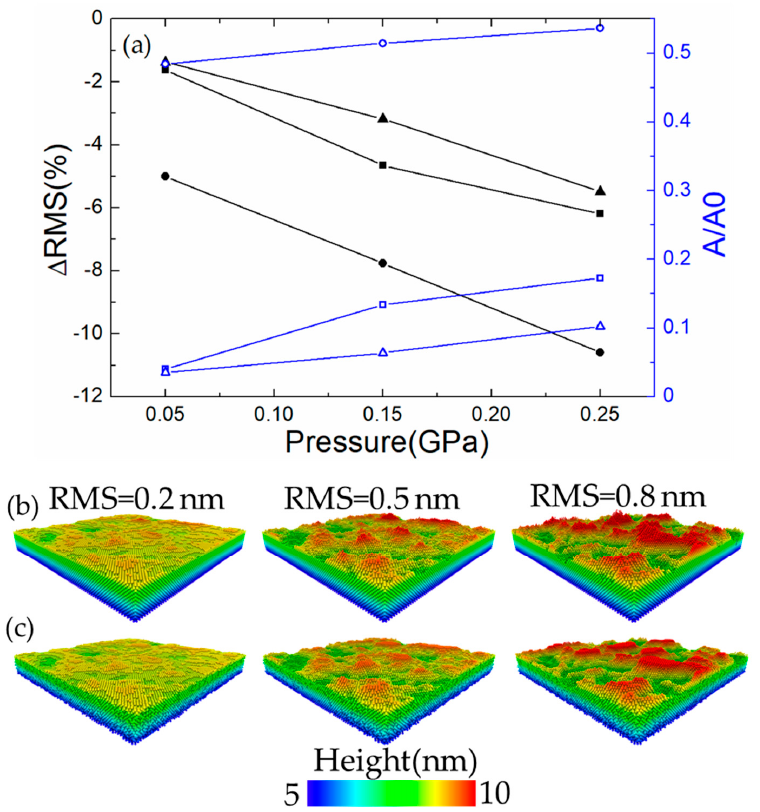
Figure 4. ( a ) RMS change ∆ RMS and contact area A / A0 of dry contact as a function of pressure. The circle, square and triangle indicate RMS = 0.2, 0.5 and 0.8 nm, respectively. Changes in the topography before ( b ) and after ( c ) loading for the surfaces with RMS = 0.2, 0.5 and 0.8 nm,